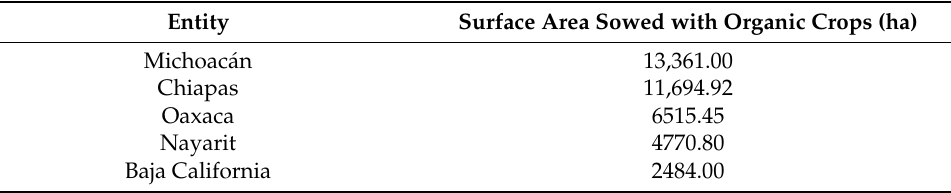
Table 1. Entities with the largest surface area sowed with organic crops in Mexico in 2019. Entity Surface Area Sowed with Organic Crops (ha) Michoac á n 13,361.00 Chiapas 11,694.92 Oaxaca 6515.45 Nayarit 4770.80 Baja California 2484.00 Source: data taken from